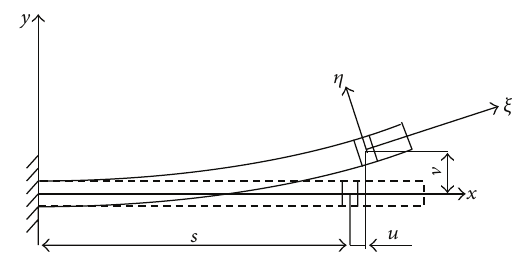
Figure 2: The nonlinear Euler-Bernoulli beam theory: undeformed coordinate system xy and the deformed coordinate system 𝜉𝜂